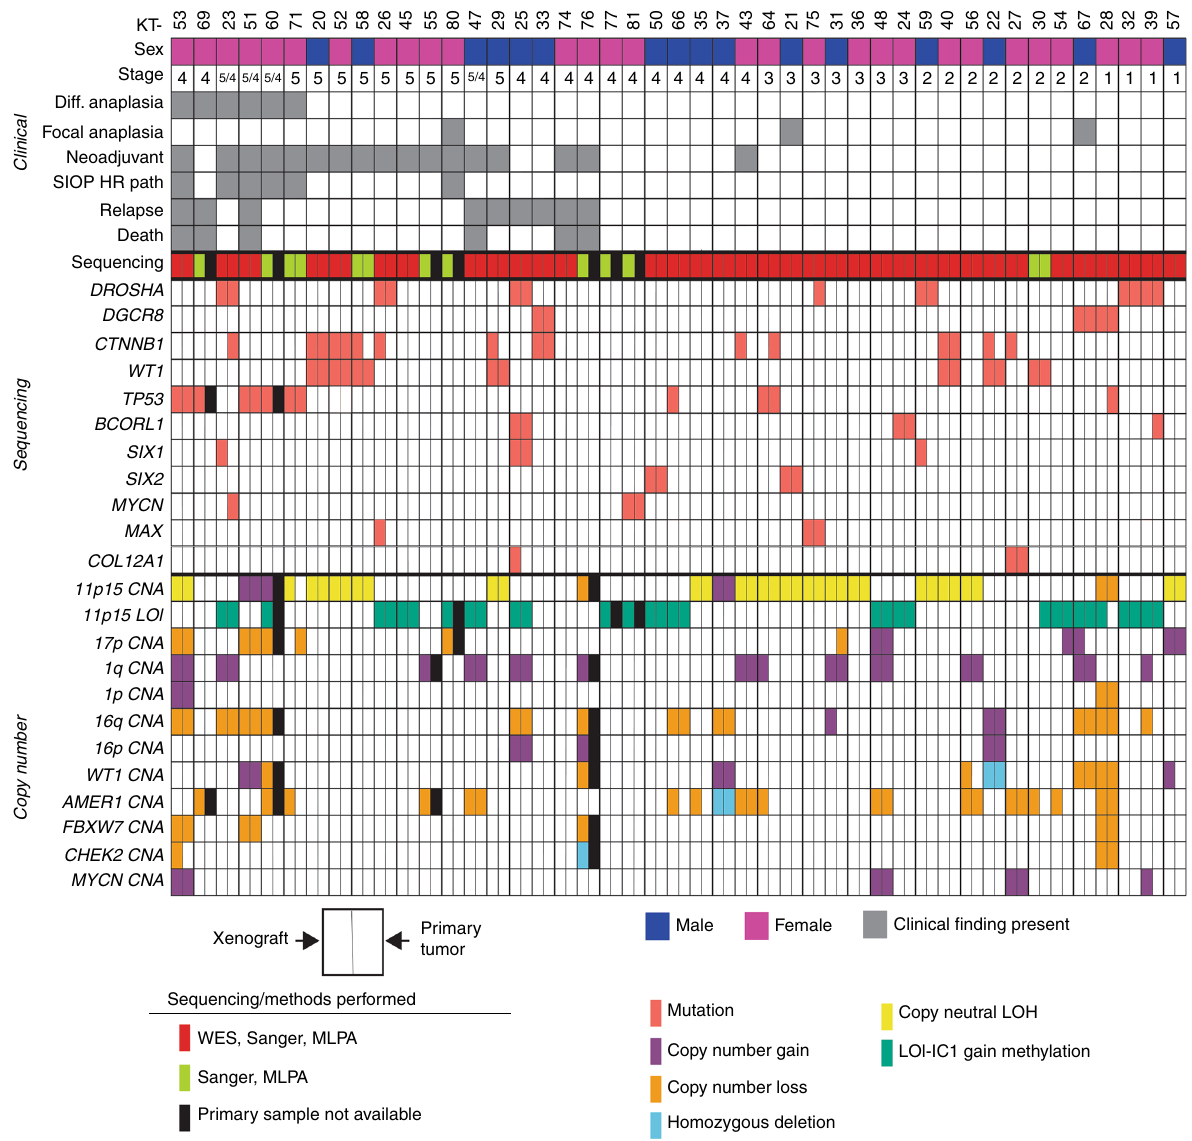
Fig. 1 45 WTPDX and corresponding primary tumors. Each KT column represents an individual xenograft. Clinical characteristics are outlined in the top panel. Children ’ s Oncology Group (COG) disease stage is indicated. For bilateral WT cases (stage 5) also with metastasis present, the stage is indicated as 5/4. Neoadjuvant indicates that the patient received neoadjuvant chemotherapy before surgical resection and establishment of the WTPDX. SIOP HR path (as per International Society for Pediatric Oncology Classi fi cation) indicates high-risk histology (diffuse anaplasia or blastemal predominance) after neoadjuvant chemotherapy. Relapse indicates that the patient later experienced relapse during the clinical course. Genetic variants and chromosomal copy number alterations (CNAs) are displayed in the lower two panels. The type of sequencing performed (WES with target capture sequencing, Sanger sequencing, or both) is shown. Each fi nding is depicted for the WTPDX — primary tumor pair, with the left rectangle representing presence of the variant or CNA in the WTPDX, and the right rectangle representing an equivalent fi nding in the parent primary tumor. An un fi lled (white) rectangle indicates absence of this fi nding in either the WTPDX or primary tumor. Specimens for which primary tumor tissue was not available are indicated by black